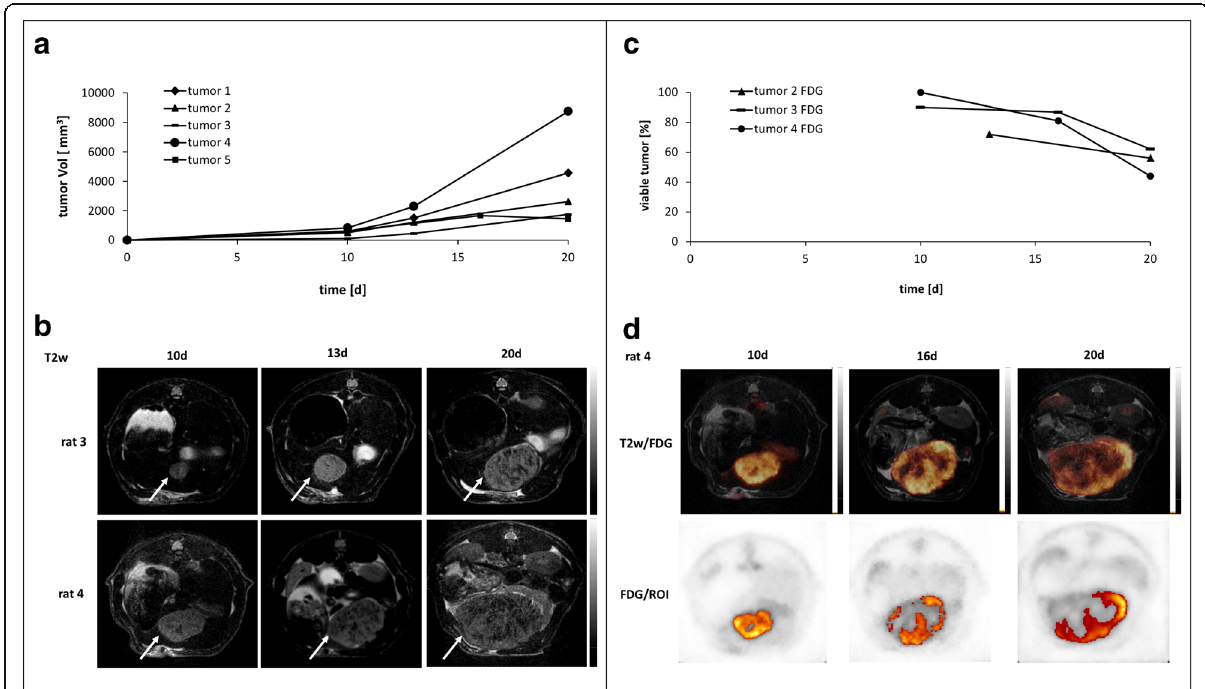
Fig. 3 a Rate of HCC growth in rats. Tumor volume was measured after 10 and 20 days, as well as 13 days for tumors 1 to 4 and 16 days for tumor 5. b Representative T2-weighted images of rat 3 (tumor: white arrow) and rat 4 (tumor: white arrow) at three different time points revealing morphologic heterogeneity due to a different tumor growth rate. Viable tumor tissue is represented by hyperintense areas within the tumor, while degraded tumor tissue including necrotic areas is represented by hypointense areas. c The FDG-avid fractions of the tumor for three rats are shown. Decreasing values indicate increasing non-metabolically active tissue. d Fused FDG-PET/T2w tumor images of rat 4 (upper row) as well as threshold-based ROIs indicating viable tumor tissue for three different time points (d10, d16,